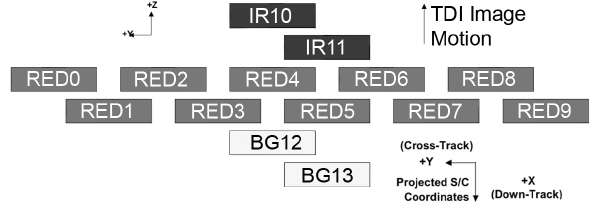
relative to RED using a grid network of points. The output is line by line (Becker et al., 2007). This produces satisfactory color registration, but does not remove the geometric distortions in an absolute sense.